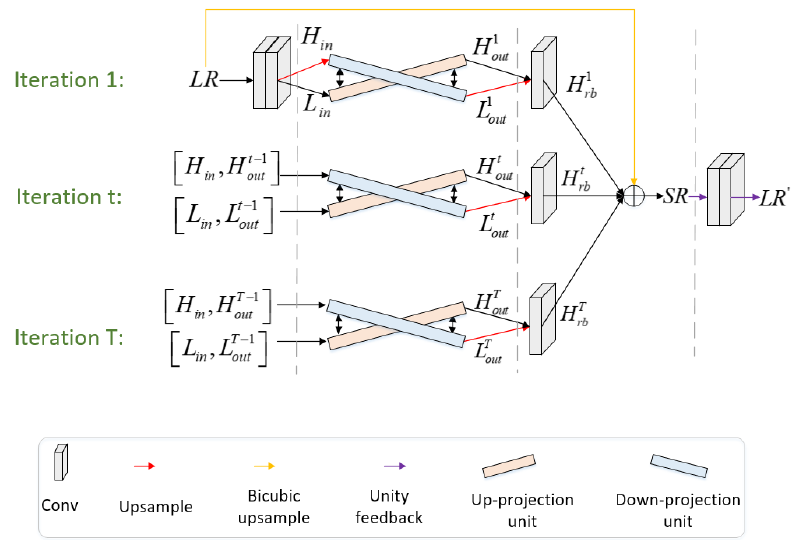
Figure 3. The unfolded